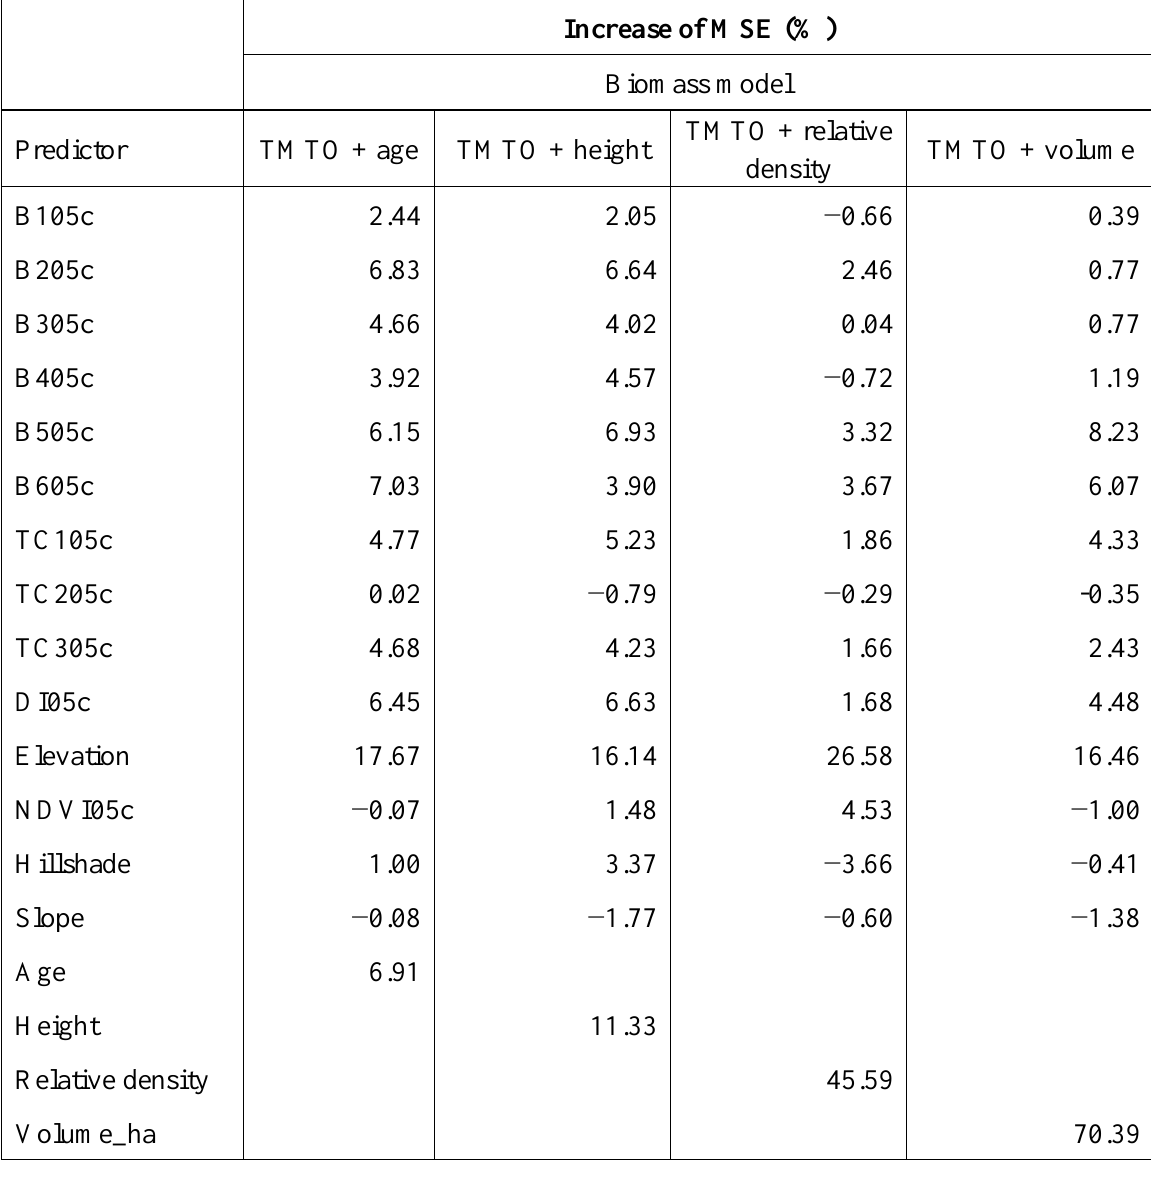
Table 5. Relative importance of predictors by TMTO model including single forest